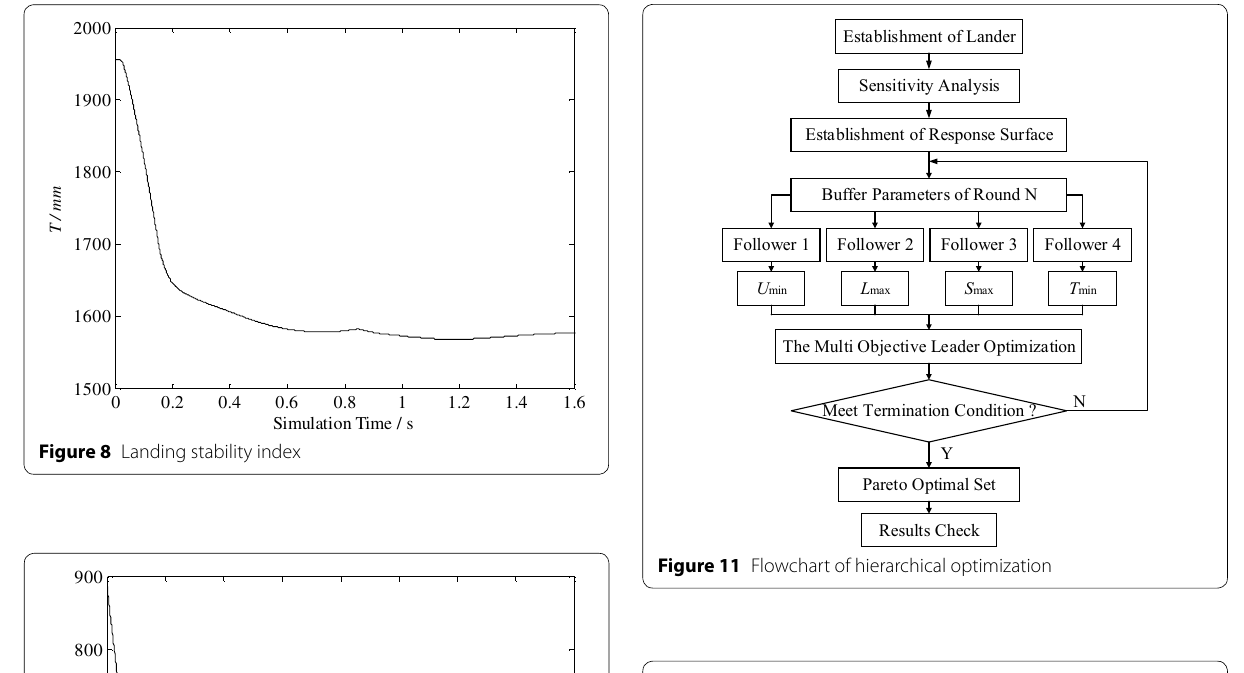
Figure 11 Flowchart of hierarchical optimization